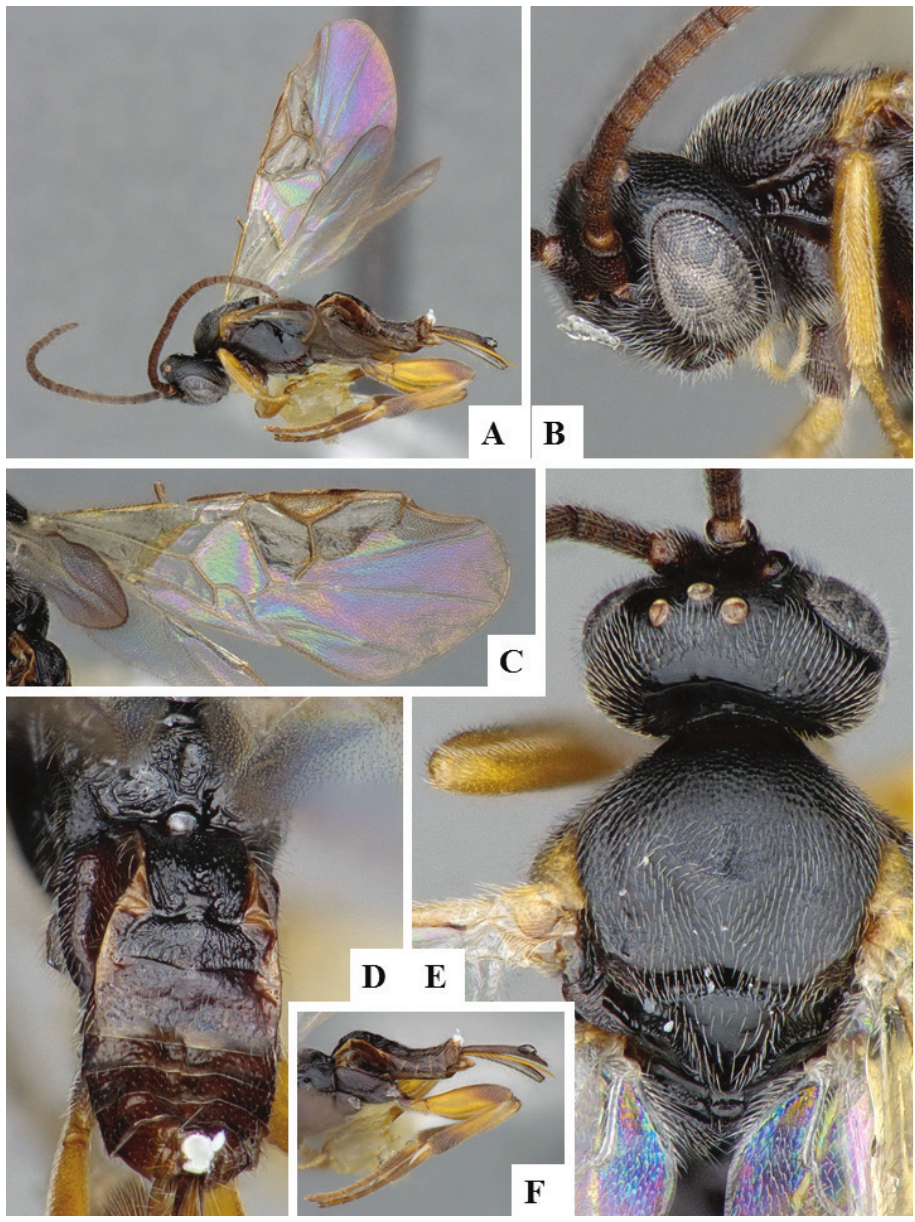
Figure 11. Apanteles polychrosidis. A Habitus, lateral B Head, lateral C Wings D Metasoma, dorsal E Head and mesosoma (partially), dorsal F Metasoma, Apanteles jft10 Distribution. NEA.